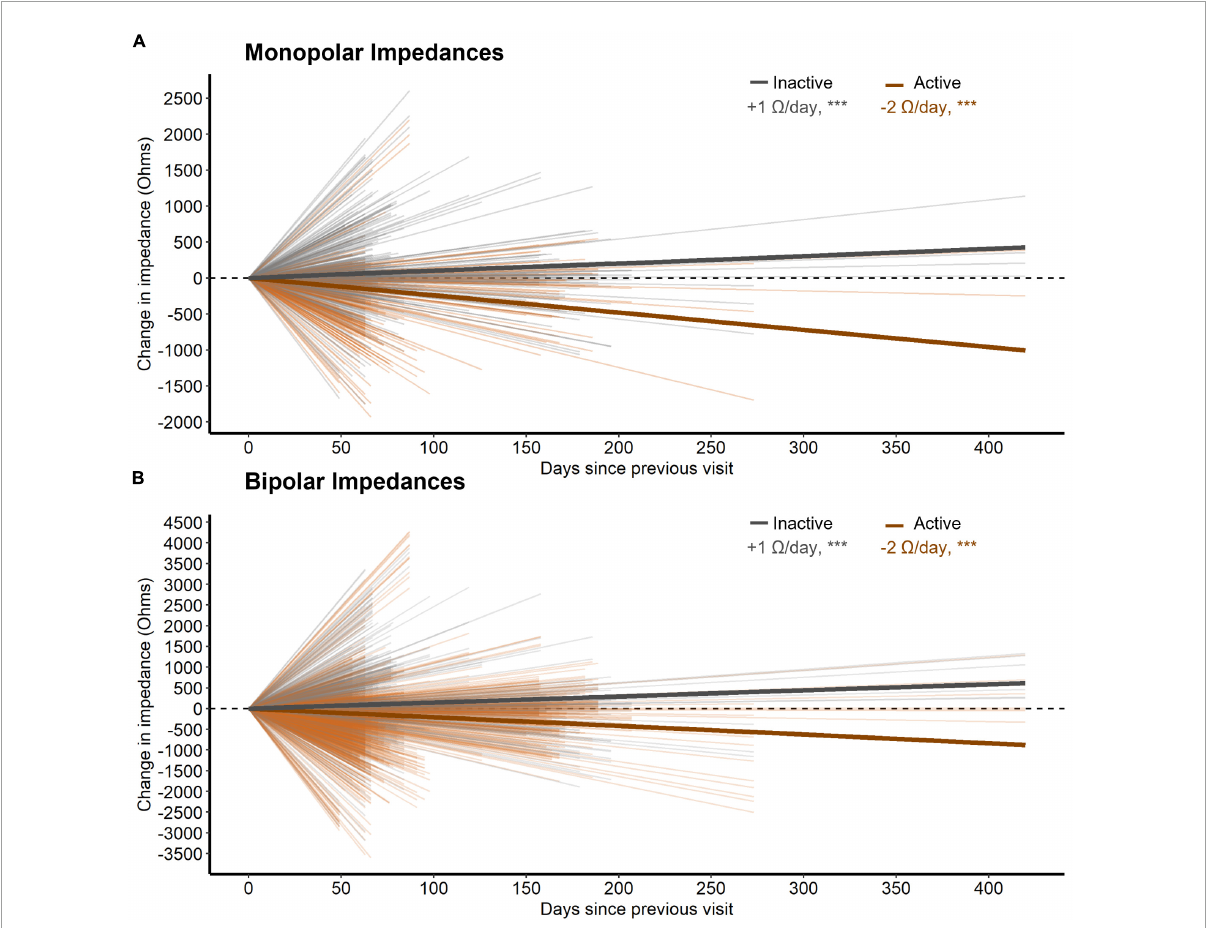
FIGURE4 (A) The change in monopolar bipolar impedance per contact between subsequent post-operative visits as a function of time measured in days. Contacts are either inactive or active during this time. Thick lines represent the slope of impedance change for inactive and active contacts as determined by a LMM. (B) Same as (A) but for bipolar impedances. Here, a bipolar pair was labeled as active if either contact was